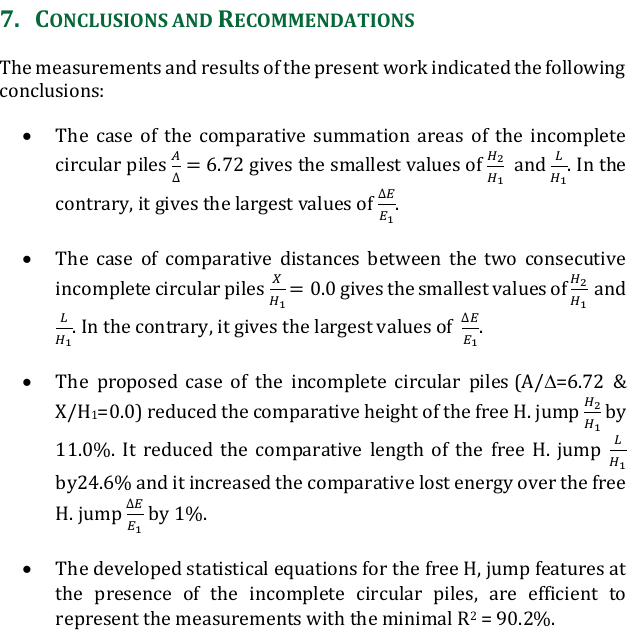
Figure 34: The relationship between the residuals’ values versus the statistical validating comparative lost energy Eq.